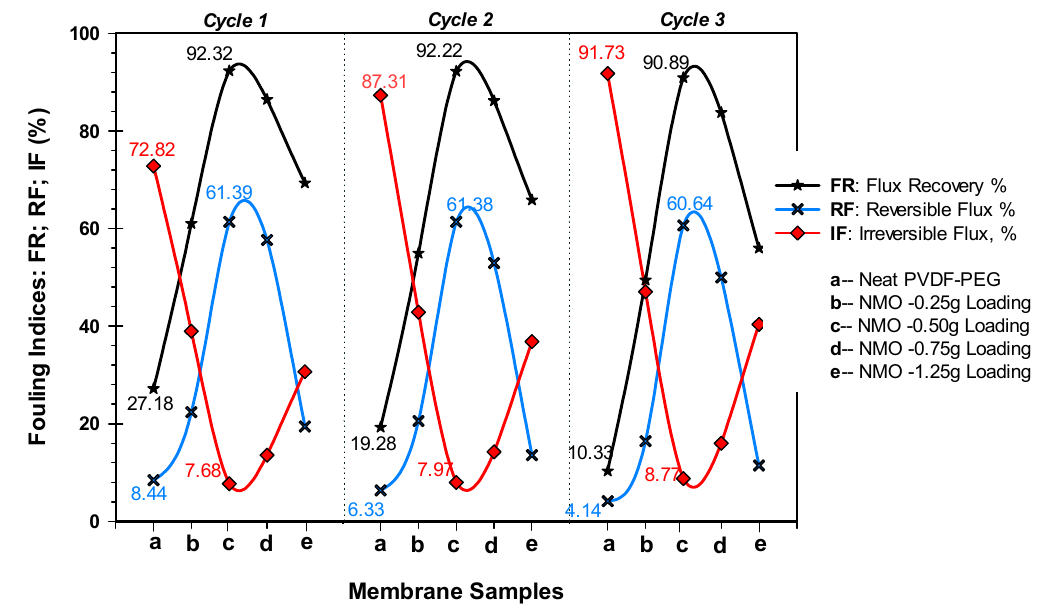
Figure 9. Fouling characteristics (FR, RF and IF) of membrane fibers during three (3) consecutive filtration cycles using POME as feed.